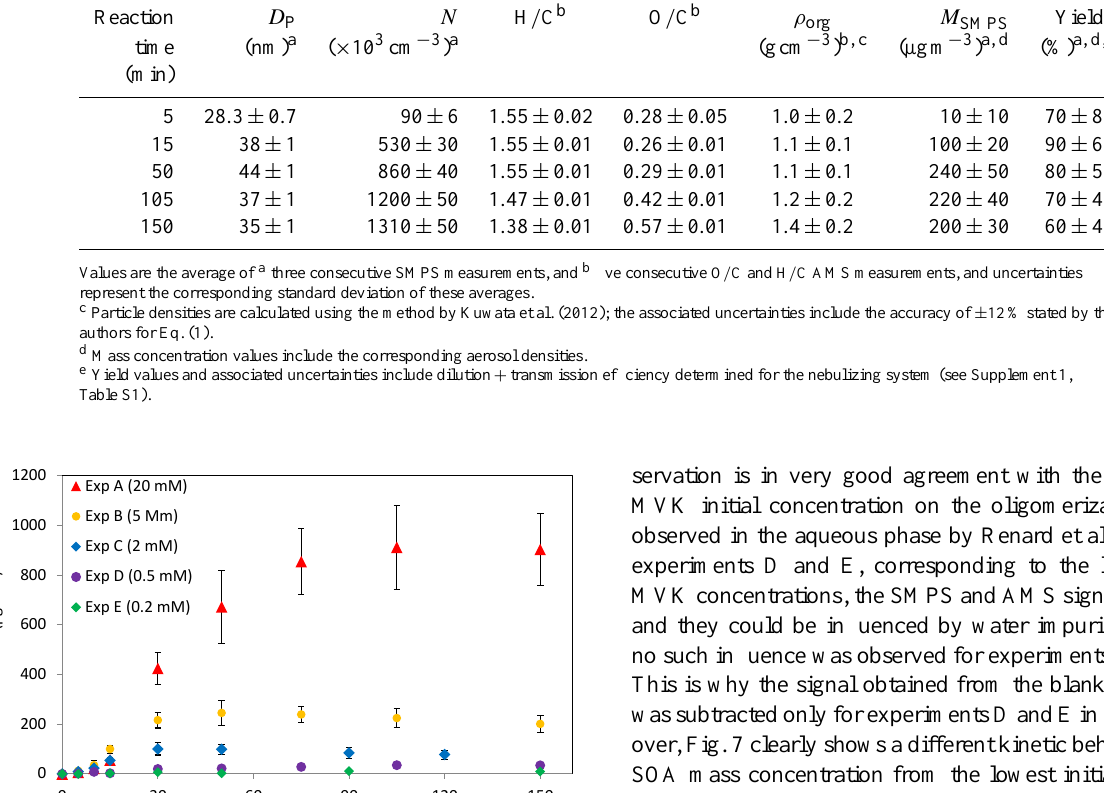
Table 2. Characteristics of the aerosol formed from nebulized MVK solutions at different reaction times for experiment B. Reaction D P